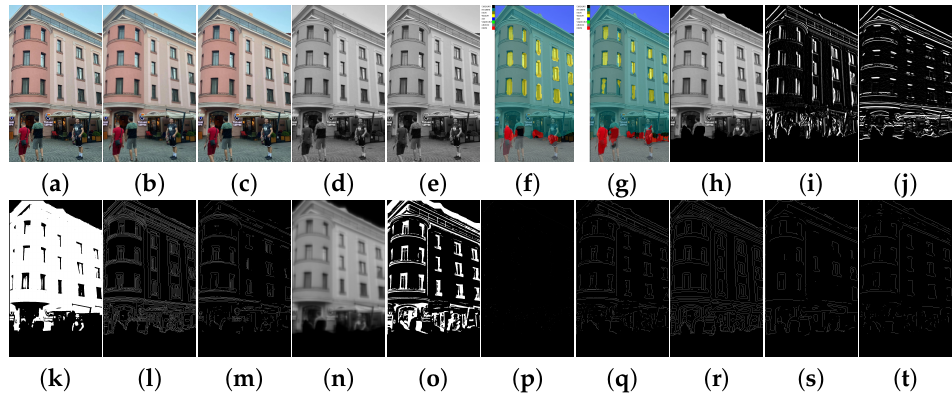
Figure 22. ( a ) Raw image; ( b ) Bilateral smoothing results; ( c ) Anisotropic smoothing results; ( d ) Gray transform of b; ( e ) Gray transform of c; ( f ) ResNet_SegNet result of a; ( g ) VGG_Unet result of a; ( h ) Intersection of f with c; ( i ) G x kernel of h. ( j ) G y kernel of h. ( k ) Otsu result of h; ( l ) Canny result of h; ( m ) ED result of h; ( n ) ISEF result of h; ( o ) Binary Laplace of h; ( p ) Zero-Crosing of o; ( q ) Shen-Castan of h; ( r ) Expanded Canny from L1; ( s ) Expanded ED from L1; ( t ) Expanded Shen-Castan from